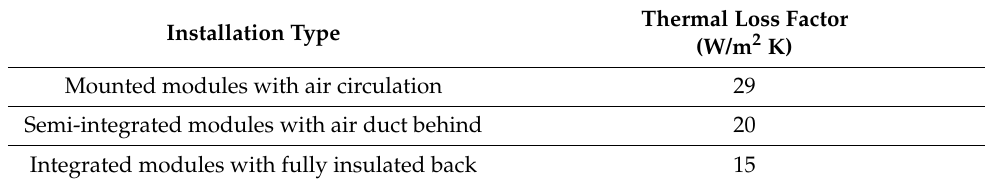
Table 1. Thermal loss factor by installation